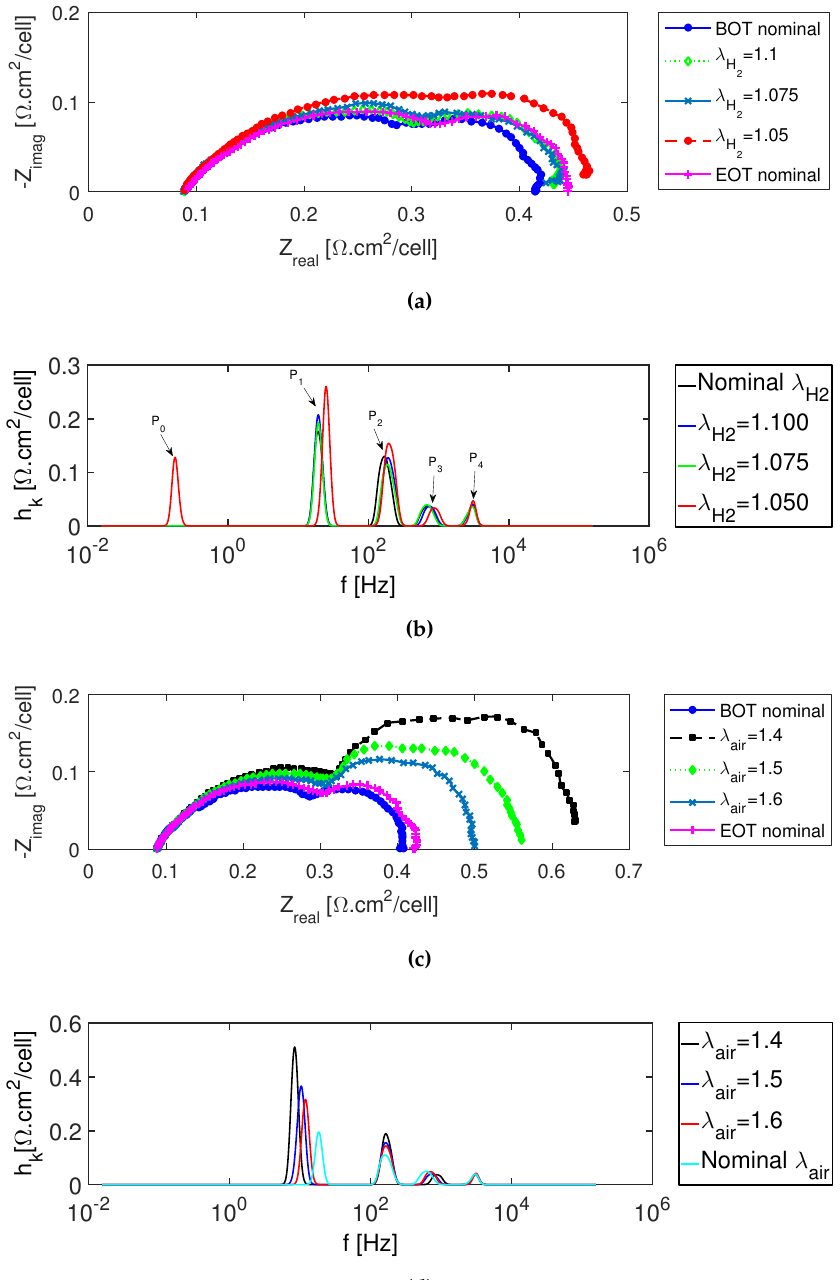
Figure 3. Starvation tests at 40 A: ( a ) anode starvation EIS spectra; ( b ) anode starvation DRT analysis; ( c ) cathode starvation EIS spectra. ( d ) cathode starvation DRT